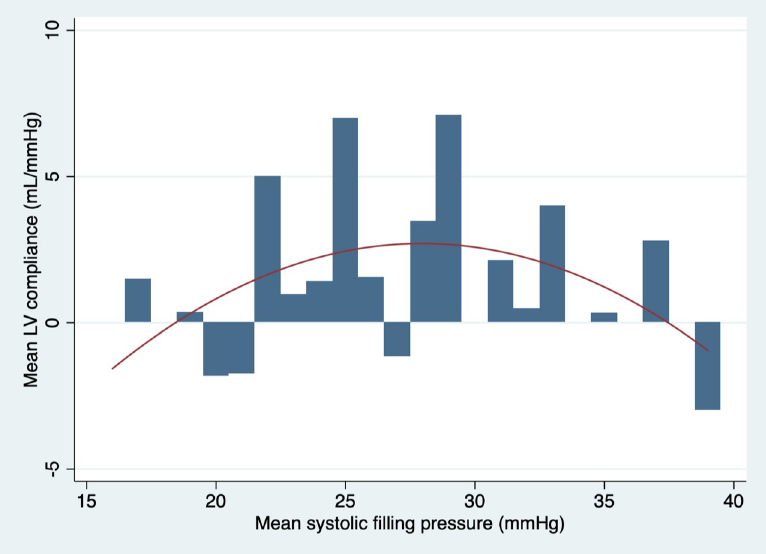
Fig 3. Graphic presentation of the mean LV compliance plotted against MSFP with a quadratic line of best fit with all sheep analysed.